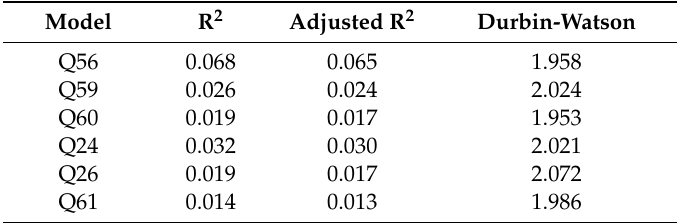
Table 3. Summary of the multiple regression analysis for the second hypothesis.